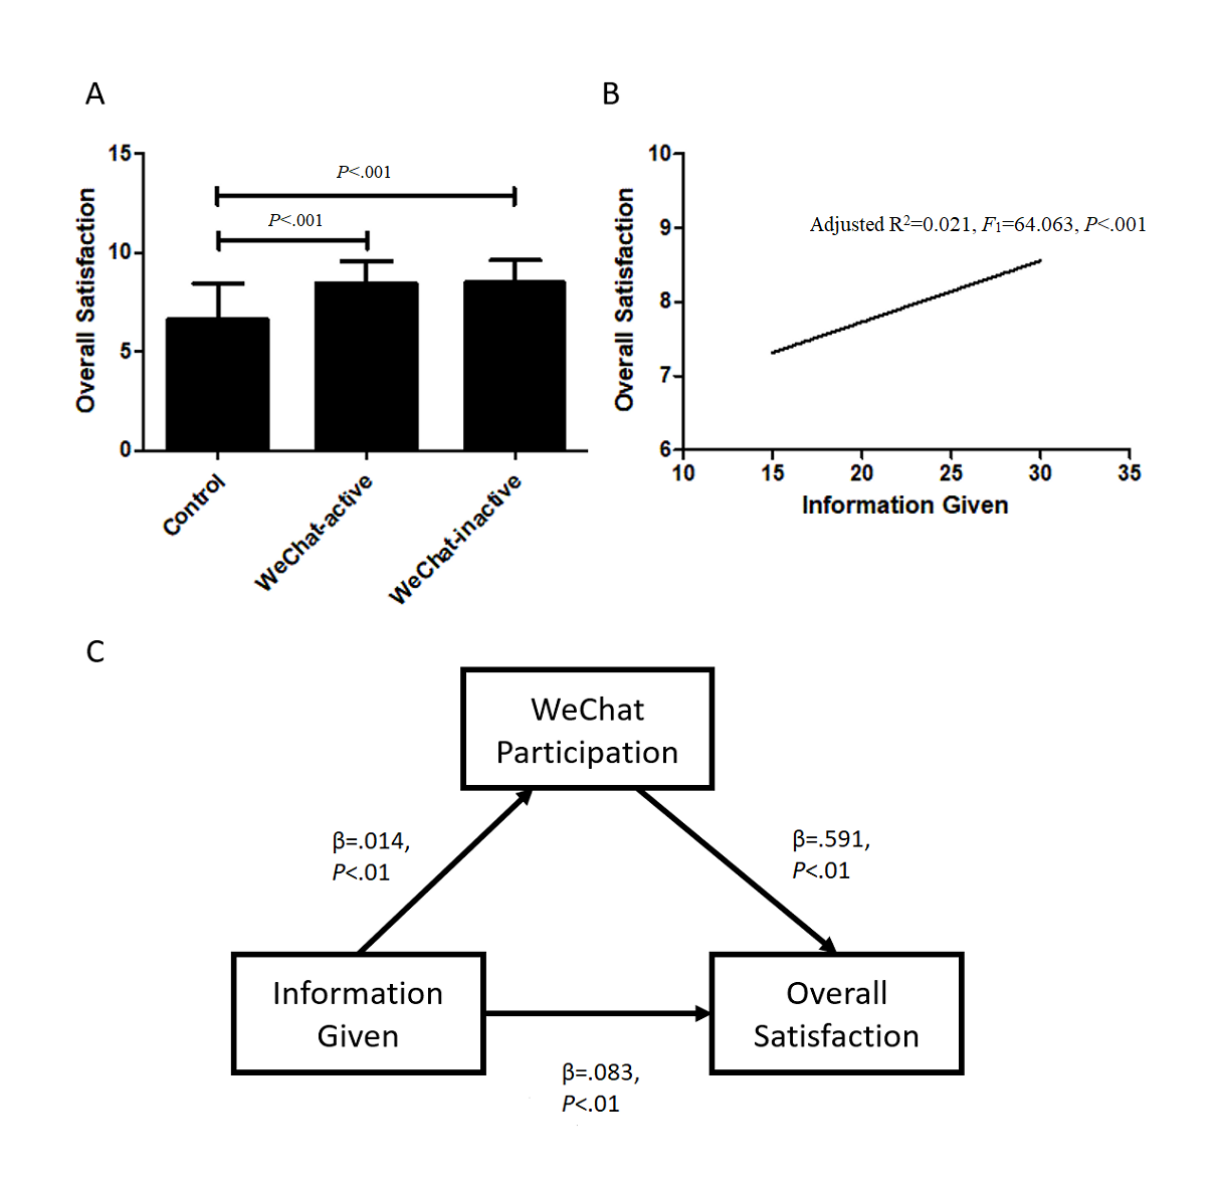
Figure 3. Data analysis from the Danish Health and Medicine Authority 2006 questionnaire. (A) Histogram shows higher overall satisfaction in active patients and inactive patients in the WeChat group than in the control group. (B) Linear regression between overall satisfaction and information given. (C) The mediated effect model among information given, WeChat participation, and overall